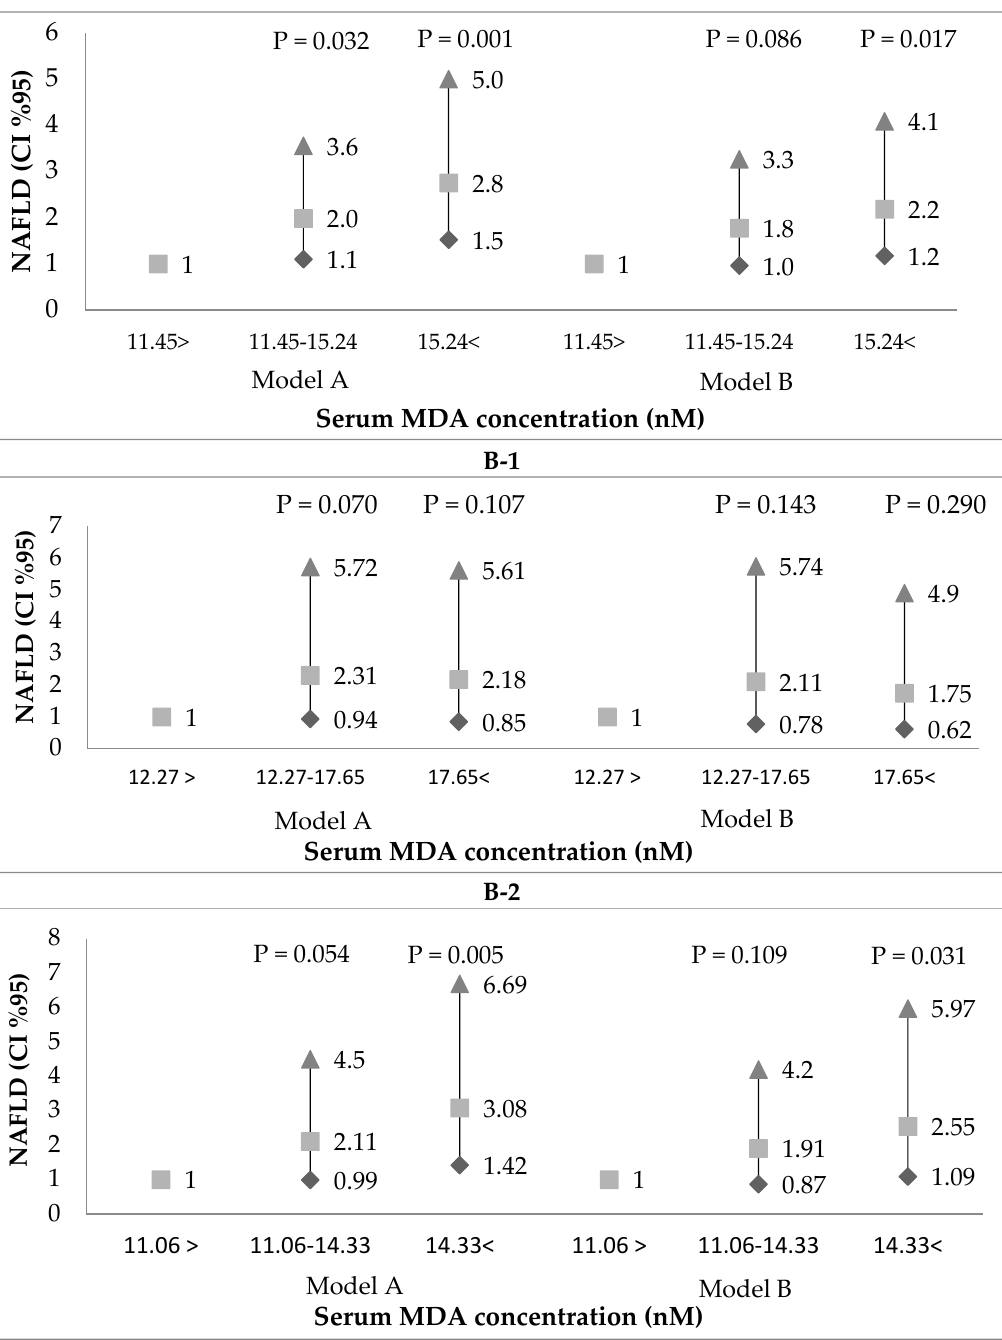
Figure 2. Univariate ( A ) and multivariate ( B ) dose response association between serum MDA concentration (nM) (tertiles, entire sample and gender specific) and NAFLD among the entire sample ( A-1 and B-1 ), women ( A-2 and B-2 ), and men ( A-3 and B-3 ). In multivariate analysis Model A adjusted for: age (years), gender (in analysis of the entire sample), BMI (Kg/m 2 ) and energy intake (Kcal/d). Model B additionally adjusted for: pack years, physical activity (h/w) SFA (% total Kcal) coffee (portions/d), total sugared beverages (portions/d) and A1C (%).